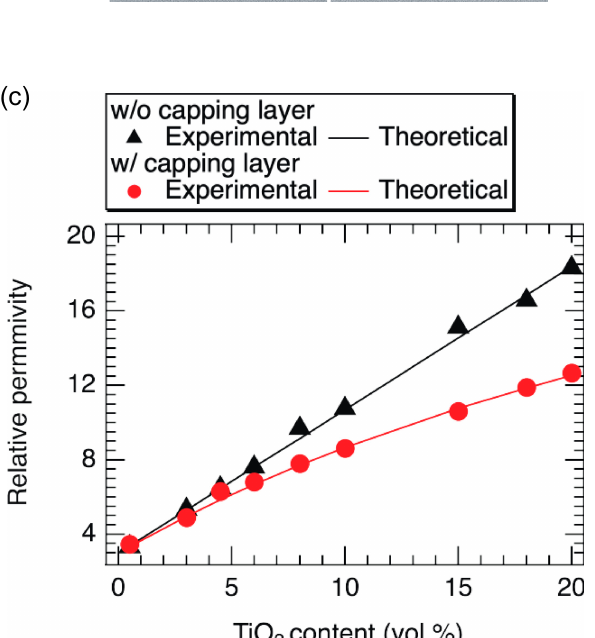
Figure 6. ( a ) The structure of the film after spin coating. ( b ) SEM images of the contents of the TiO 2 NPs at an accelerating voltage of 3.5 kV. The scale bars of the SEM images are 1 μ m. ( c ) The relationship between the relative permittivity and the content of TiO 2 NPs in the films with and without the capping layer.